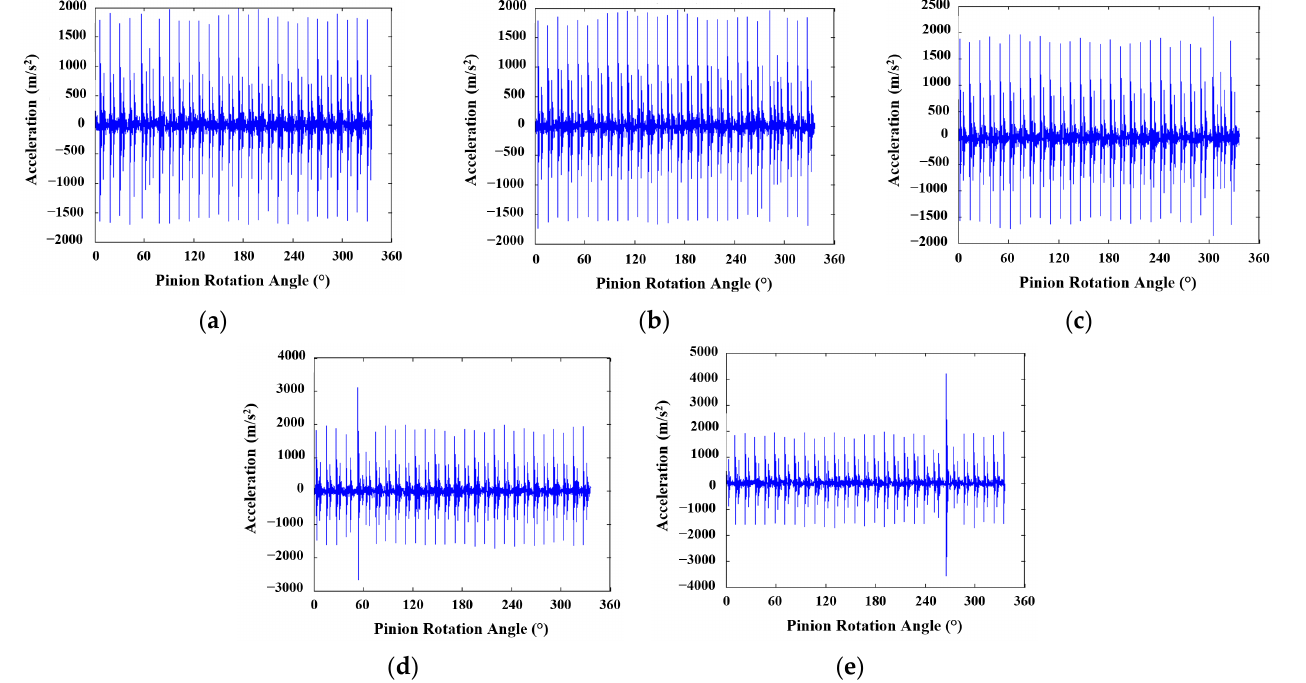
Figure 11. Vibration signals obtained for 20°/30° tooth pro fi le and SNR 15: ( a ) healthy; ( b ) 25%; ( c ) 50%; ( d ) 75%; ( e ) 100% crack levels. After three tests, the average fault classi fi cation accuracies for the standard (20°/20°) pro fi led involute spur gears were obtained as 79.854%, 91.274%, and 95.100% for SNR values of 5, 10, and 15, respectively. Accordingly, the present study acquired overall clas- si fi cation accuracies for the 20°/25° tooth pro fi le as 88.323%, 95.804%, and 99.195% under